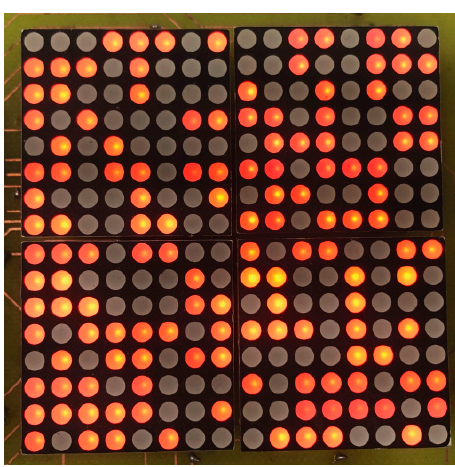
Figure 7. 256 random binary signals.